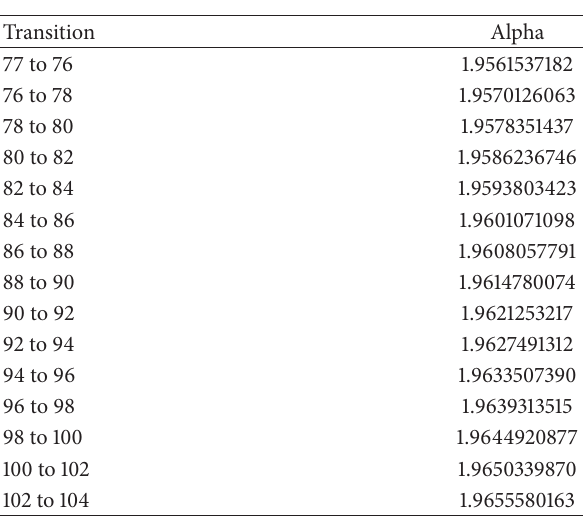
Figure 13: Typical Mittag-Leffler function in [ ∞/𝑓 ].